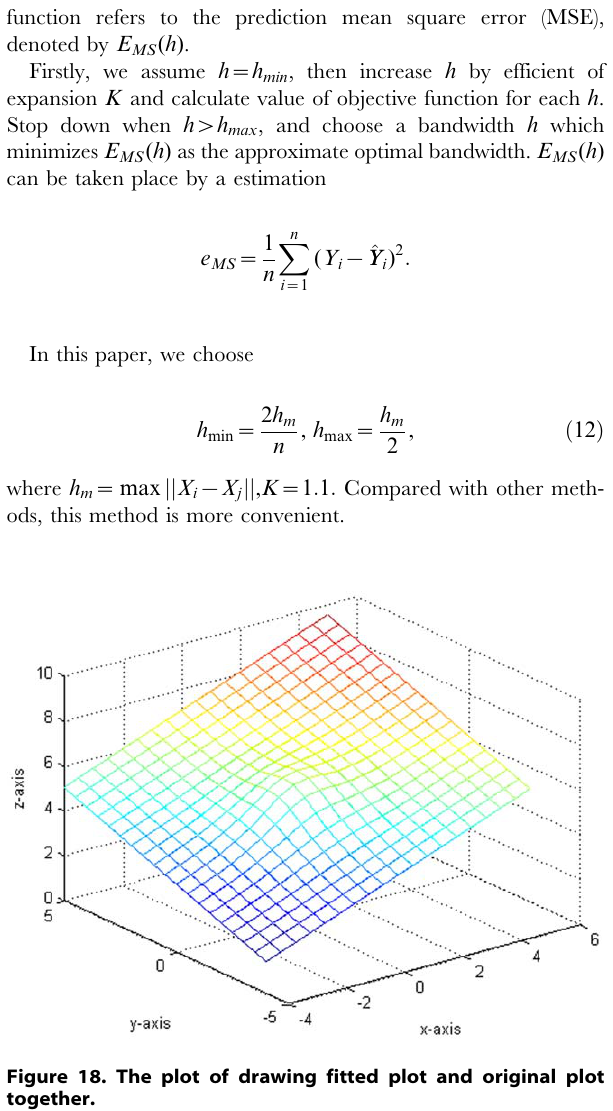
Figure 17. The original plot of the variance